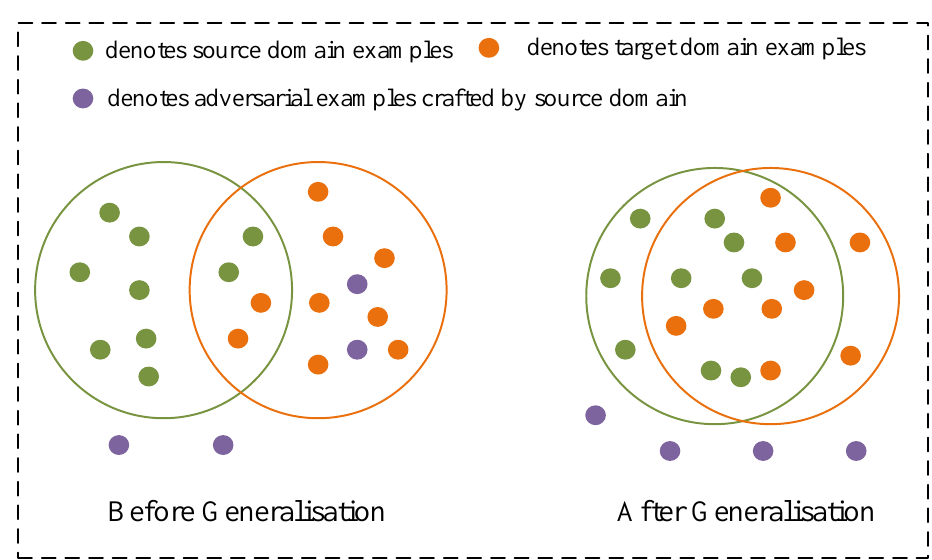
Figure 1. The relationship of the distribution of adversarial examples in different domains.